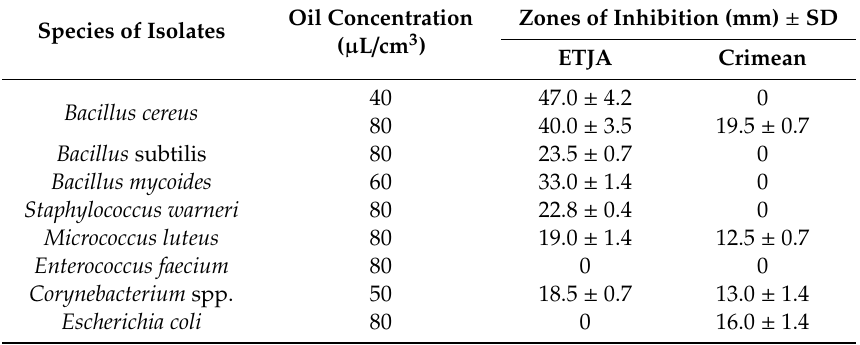
Figure 5. Stimulation of Bacillus mycoides growth in the presence of a low concentration (10 or 20 µL/cm 3 ) of Crimean lavender oil. Table 5. Zones of growth inhibition of dominant bacterial